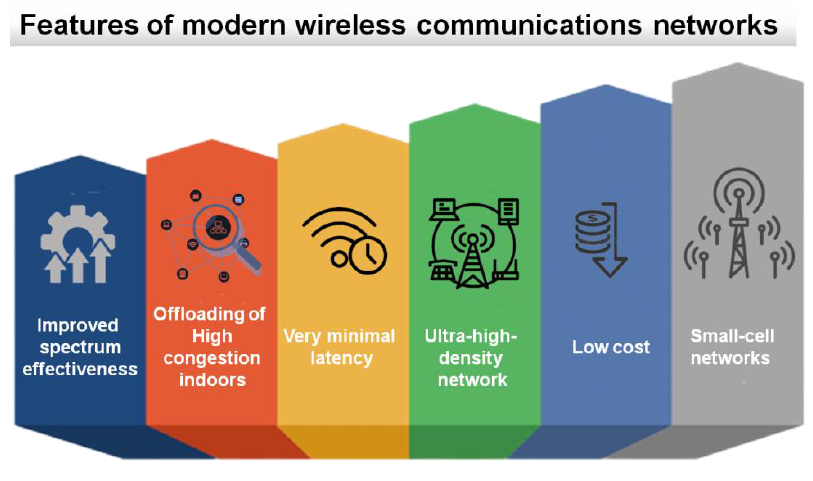
Figure 1. Features of MWCN.